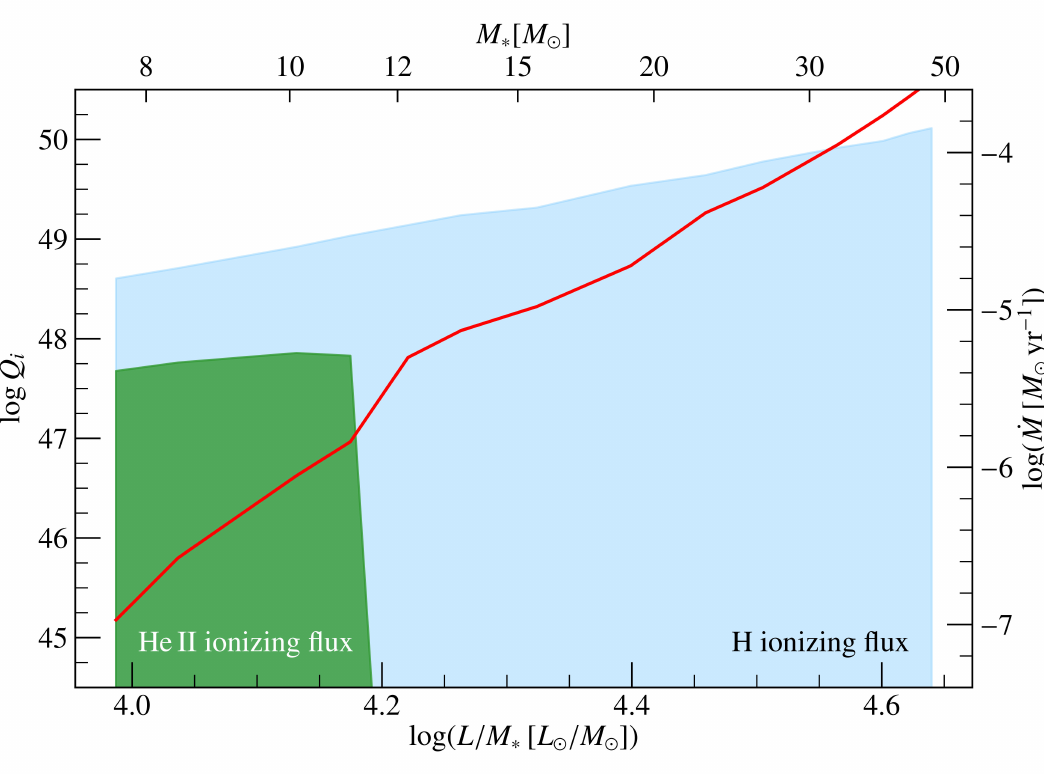
Figure 5. Ionising flux and mass-loss predictions from PoWR hydro-dynamical simulations. The red line indicates mass-loss rates (right-hand y-axis) vs. stellar M (top x-axis) and L / M ratio (bottom x-axis) for the He main sequence. Ionising fluxes (left-hand y-axis) are indicated with blue/green Boxes. Whilst the H ionising flux (blue box) varies gradually with M and mass-loss rate, the He II ionisation flux (green box) changes abruptly by a factor > 1000 at a critical L / M (cid:39) 4.2 (from Sander et al.